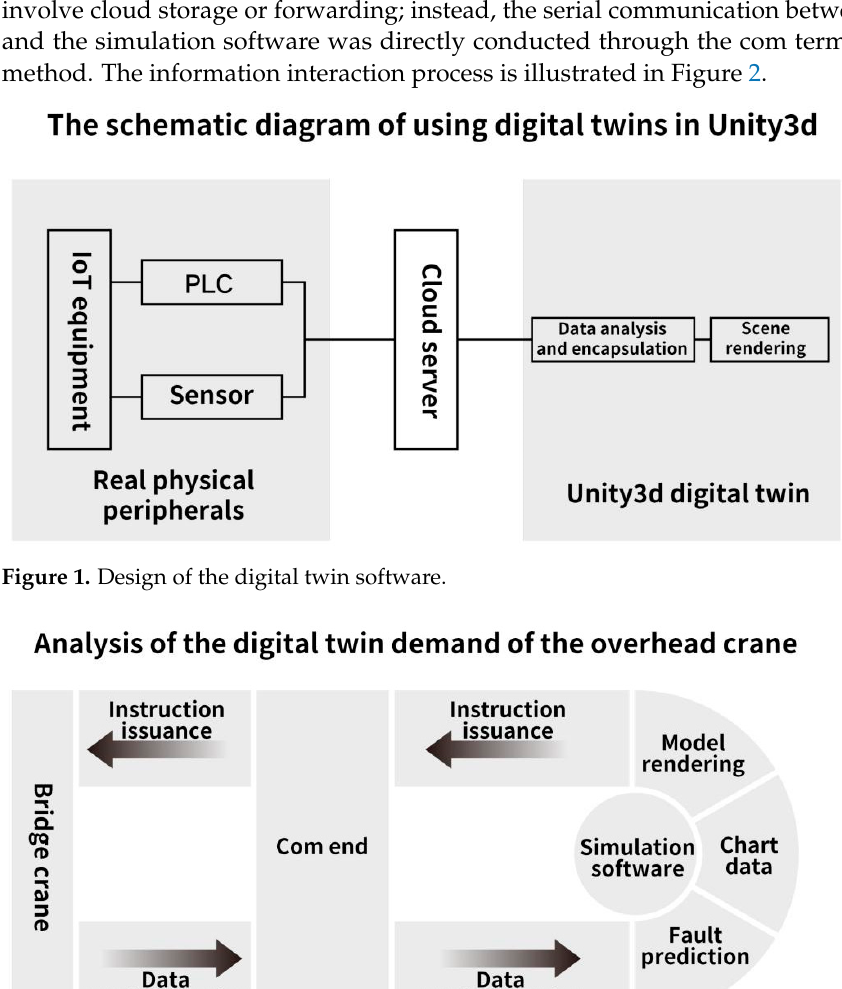
Figure 2. The data exchange of the overhead crane.